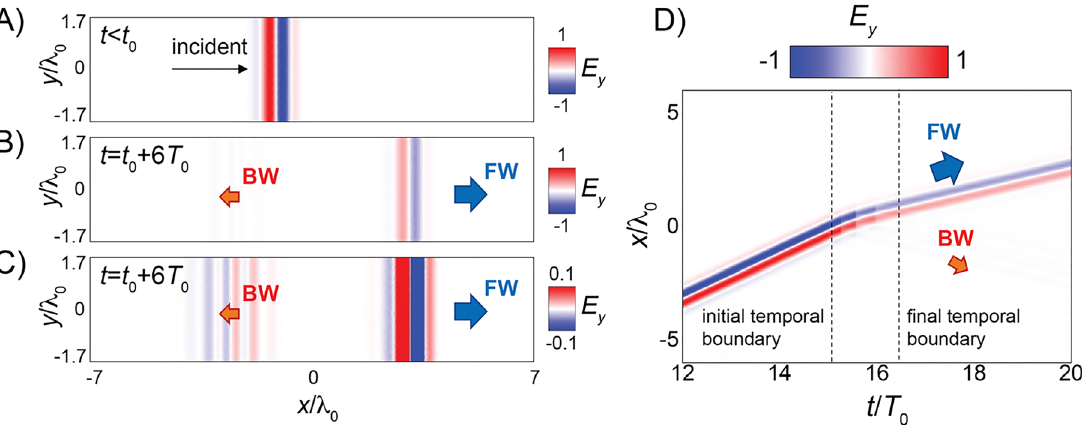
Figure 3: Parameters as in Figure 2 (binomial design), but broadband pulsed excitation. (A), (B) Numerically computed instantaneous field maps (normalized electric field) at time instants before the initial temporal boundary and after the final one, respectively. (C) Same as panel (B), but with a saturated color scale, so as to better highlight the BW component. (D) Corresponding space-time map, with the vertical dashed lines indicating the initial and final temporal boundaries.